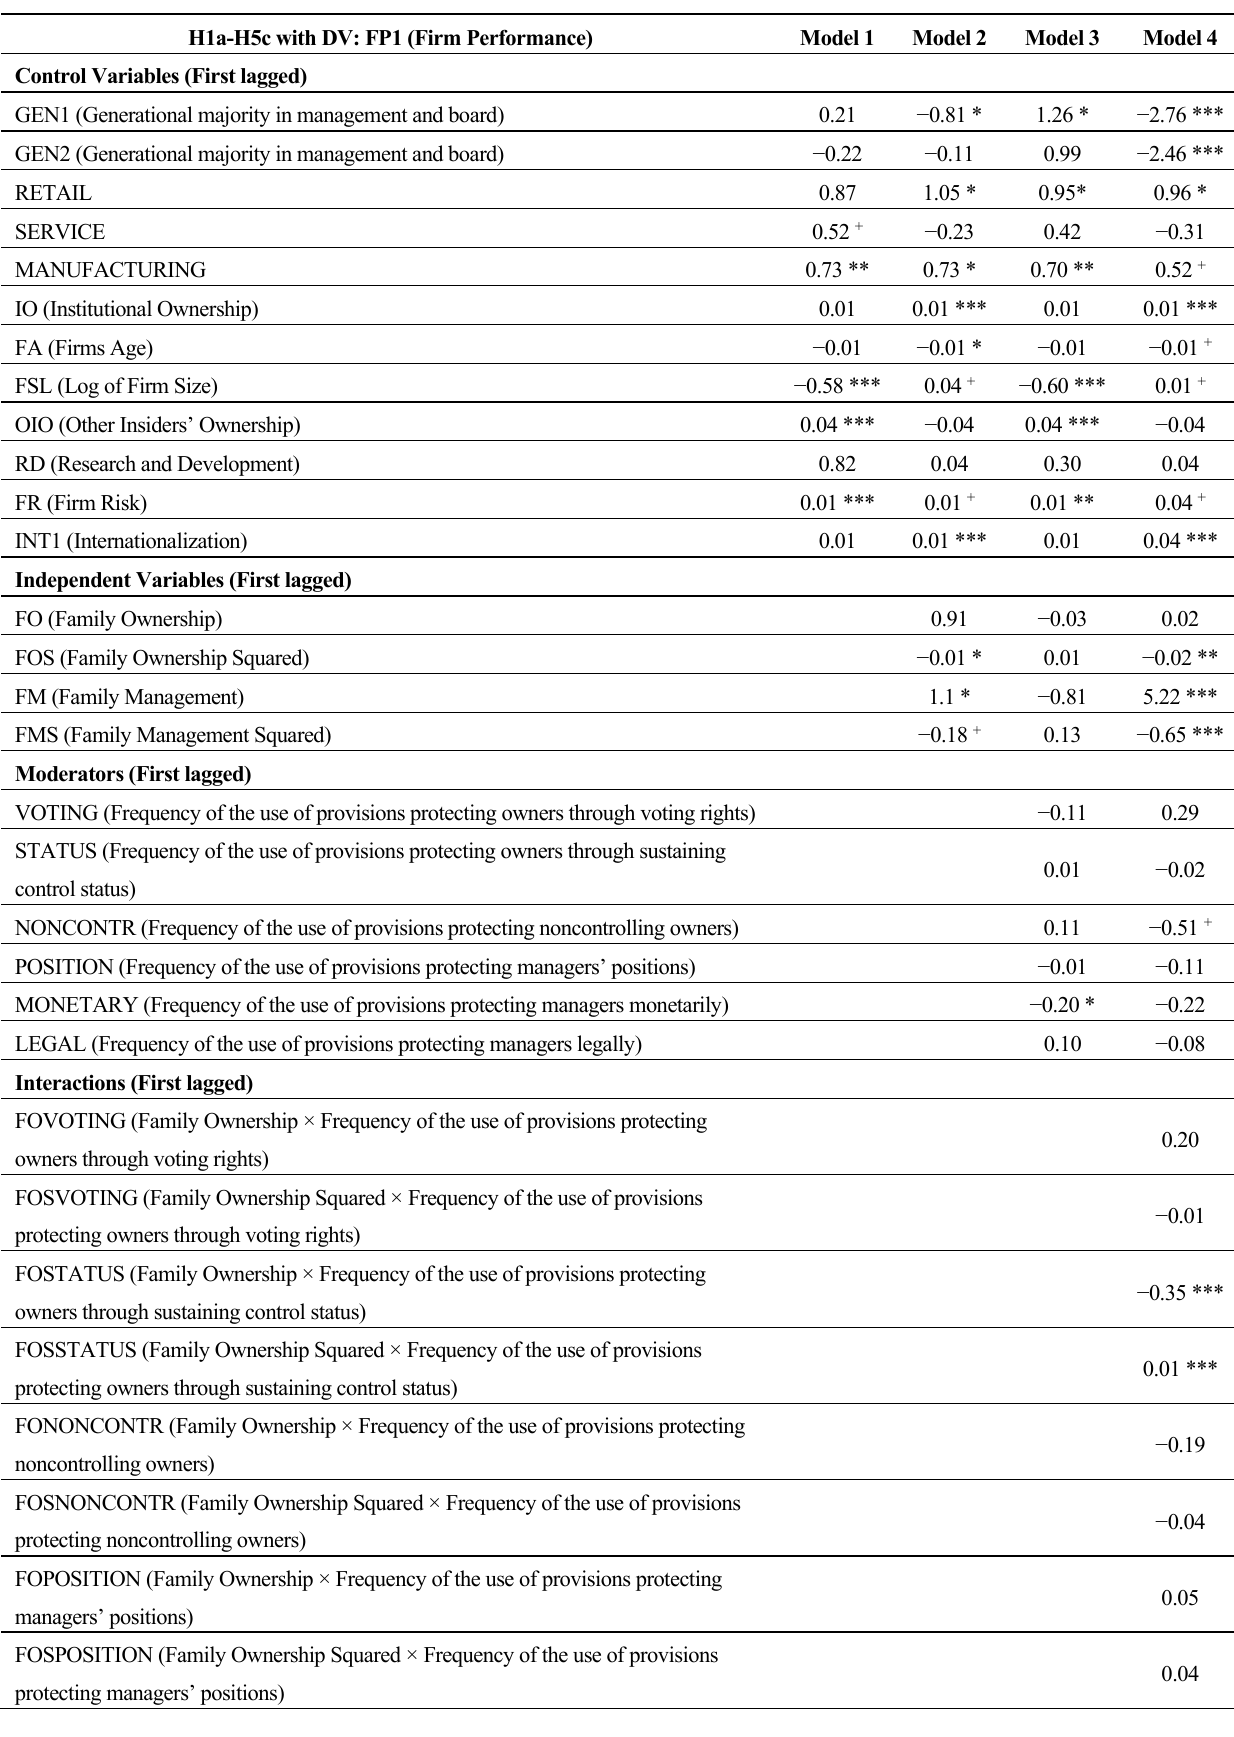
Table 3. Results of